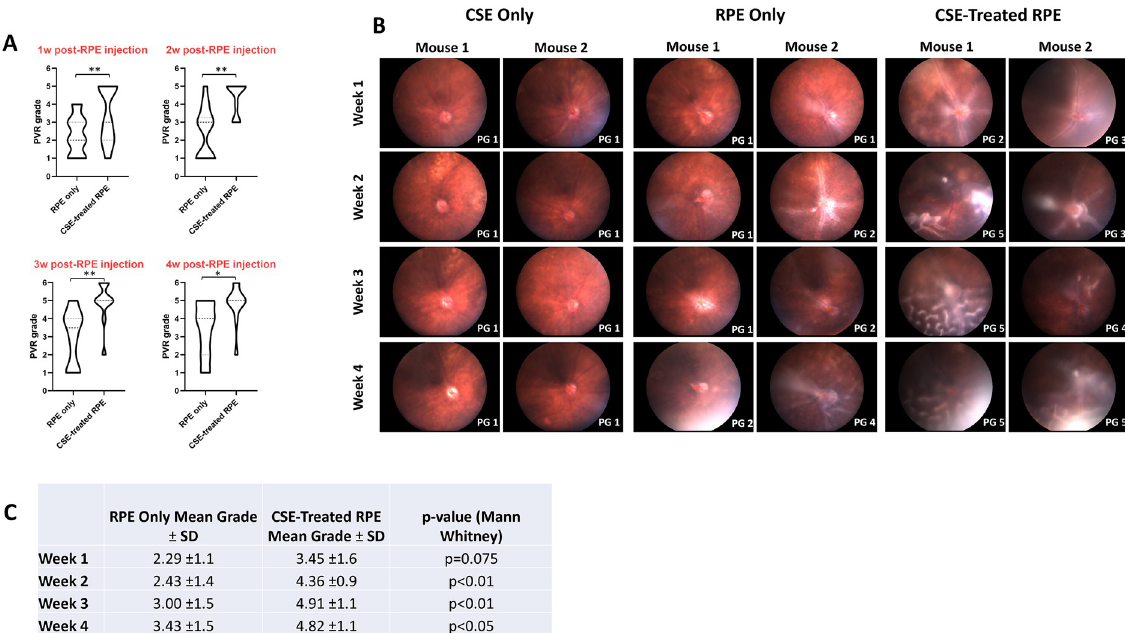
Fig 3. Intravitreal injection in mice with CSE-treated RPE cells resulted in more rapid and severe PVR development. RPE only injections consisted of 2,000 ARPE-19 cells resuspended in 1uL media (N = 14). CSE-treated RPE injections consisted of 2,000 ARPE-19 cells cultured and resuspended in 0.5% CSE (N = 11). PVR grades are based on fundus photography. (A) Both RPE only and CSE-treated RPE injected eyes developed more severe PVR over time, although CSE-treated RPE injected mice developed significantly worse PVR at every timepoint. (B) Representative fundus images of eyes injected with CSE only, RPE only, or CSE-treated RPE at each timepoint. Assigned PVR grade (PG) is listed bottom right of each image. (C) Table comparing mean PVR grades of eyes injected with RPE only or CSE-treated RPE cells.